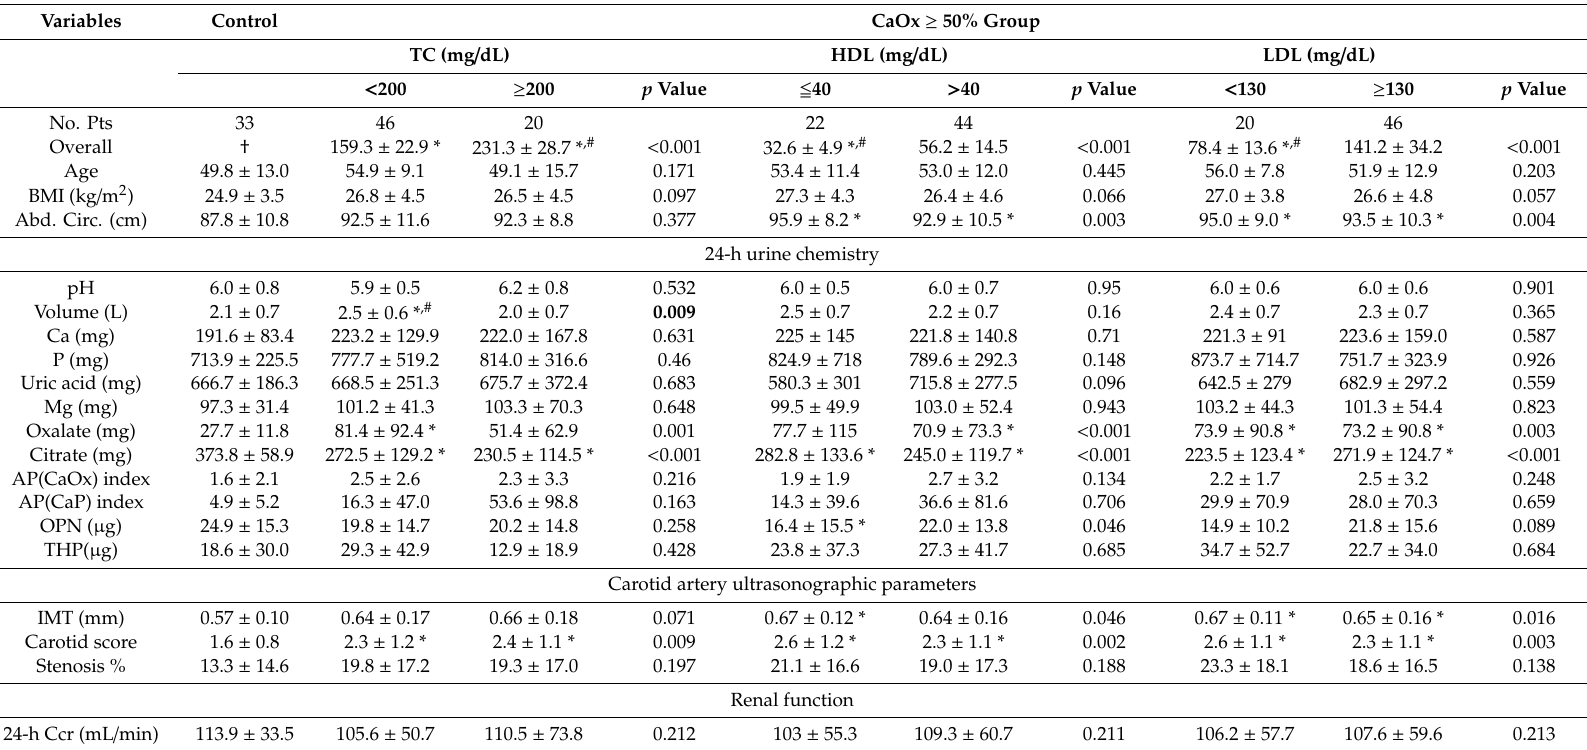
Table 2. Demographic, 24-hour urinary chemical data, and carotid score in the CaOx ≥ 50%